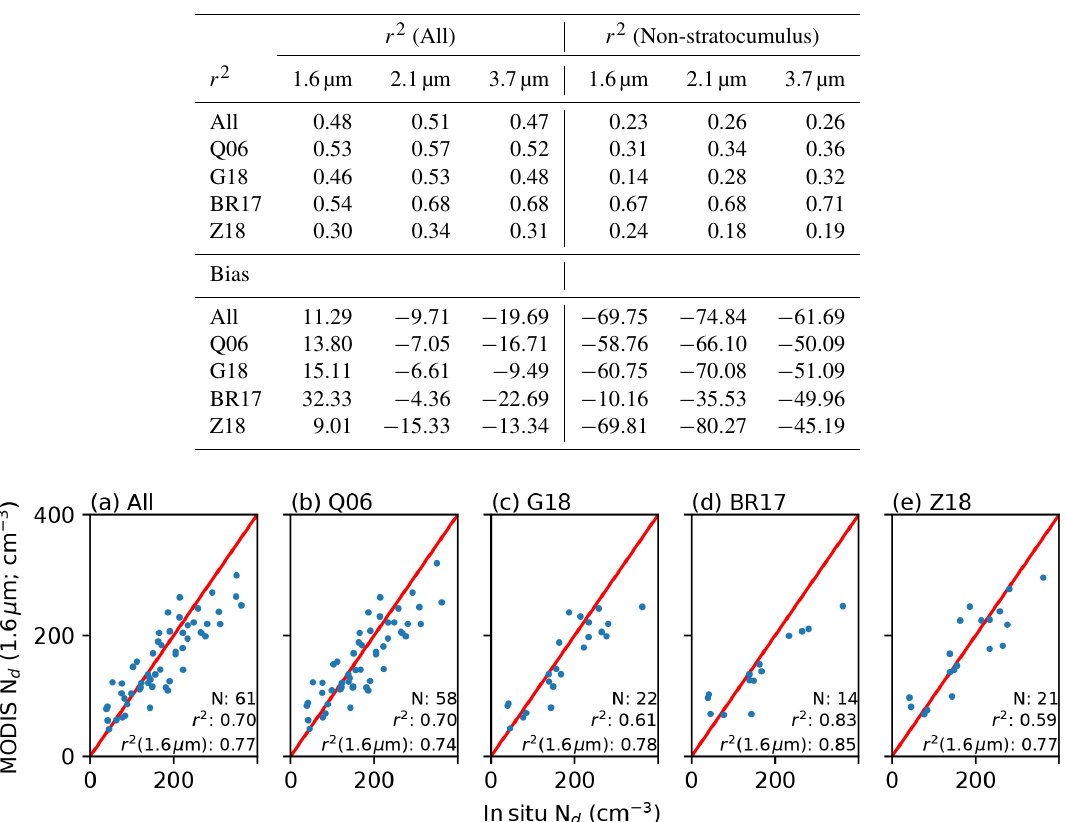
Table 3. The impact of r e wavelength on the total r 2 . The second set of values is for only the non-stratocumulus campaigns.